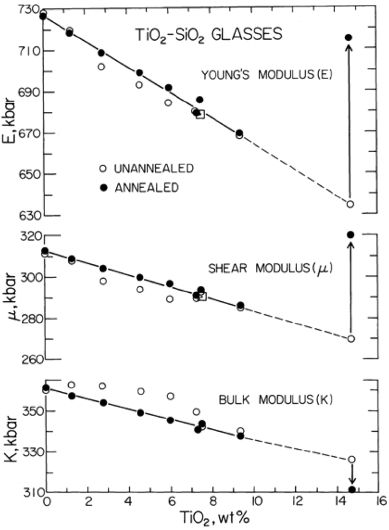
Figure 3. Bulk ( K ), shear ( µ ) and Young’s ( E ) moduli versus TiO 2 content. Annealing causes an increase in K , and a decrease in µ and E . Squares are McSkimin’s (unpublished) 1972 data. Error bars are smaller than the symbols.